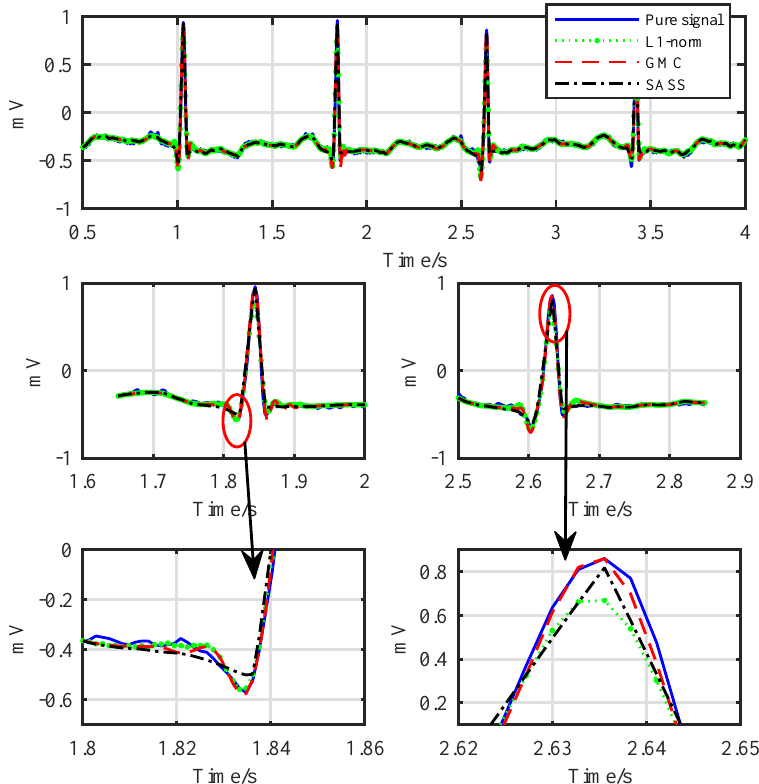
Figure 8. Comparison of the recovered signals in time domain.